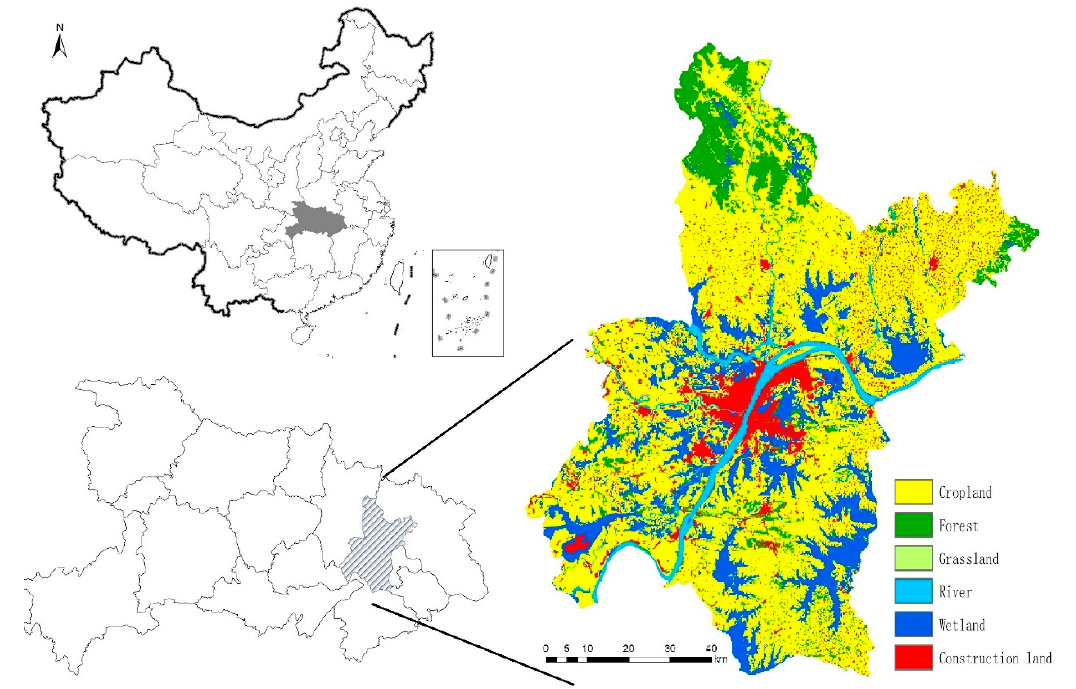
Figure 1. Location and land use of the study area.